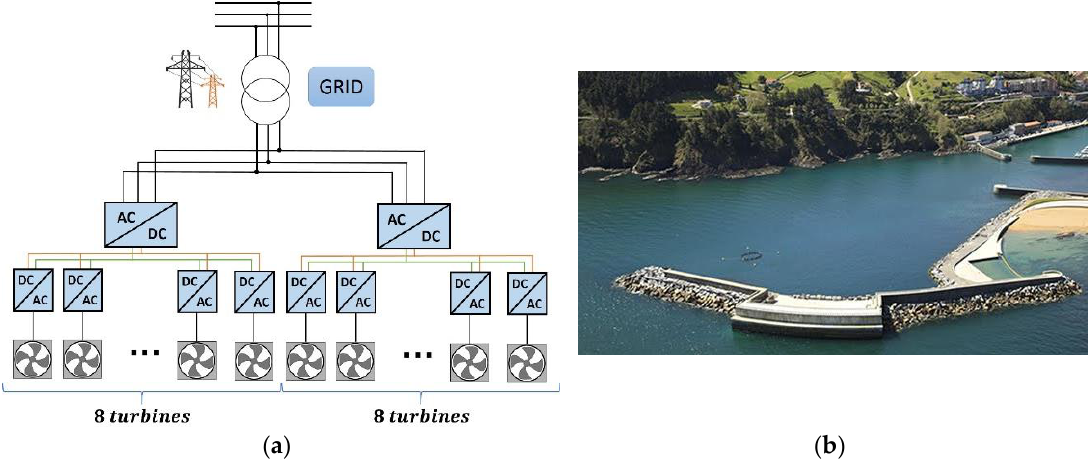
Figure 1. ( a ) Mutriku wave energy conversion (WEC) plant scheme; ( b ) Mutriku WEC plant